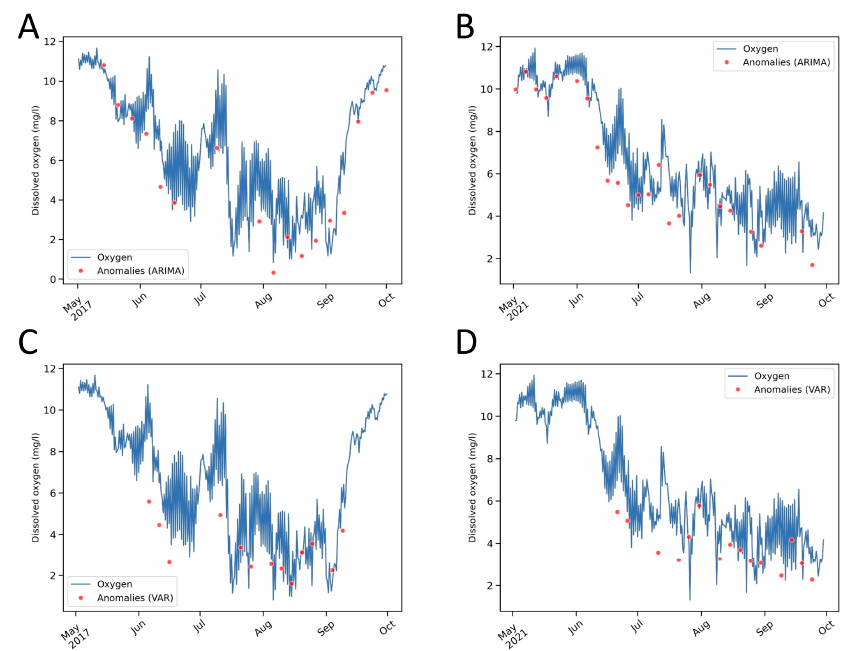
Figure 13. Time-series analyses of measured DO levels with detected anomalous points re-sampled over a week (red dots): ( A ) ARIMA model for 2017 data; ( B ) ARIMA model for 2021 data; ( C ) VAR model for 2017 data; ( D ) VAR model for 2021 data.